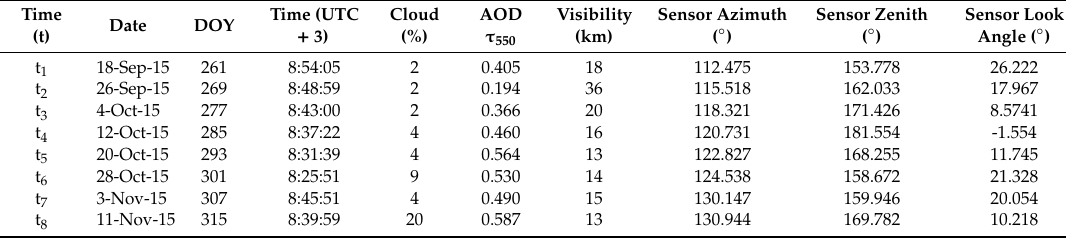
Table 1. Scene collection conditions from the Hyperion metadata